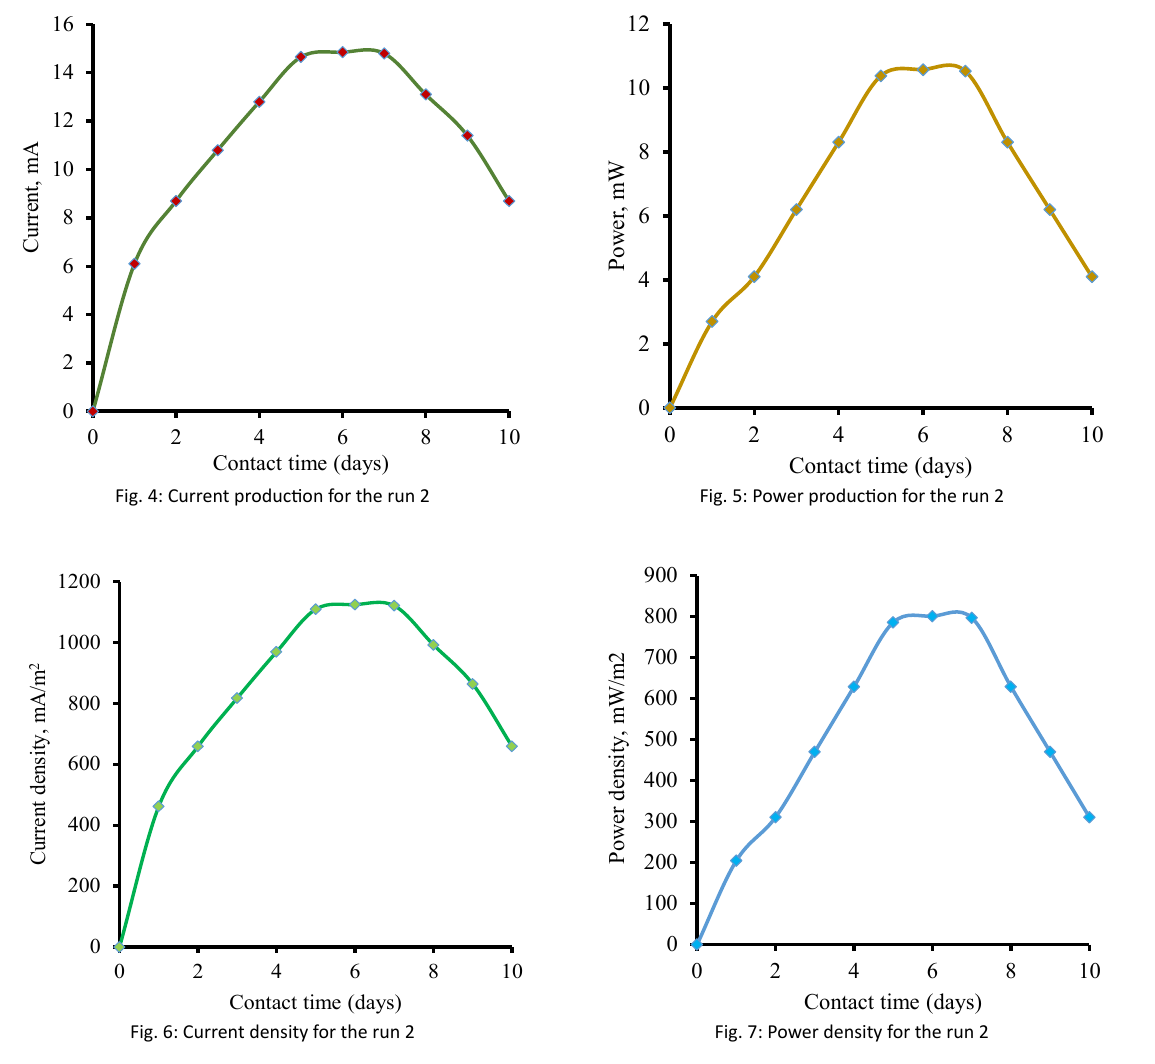
Fig. 4: Current production for the run 2 Fig. 5: Power production for the run 2 Fig. 5: Power production for the run